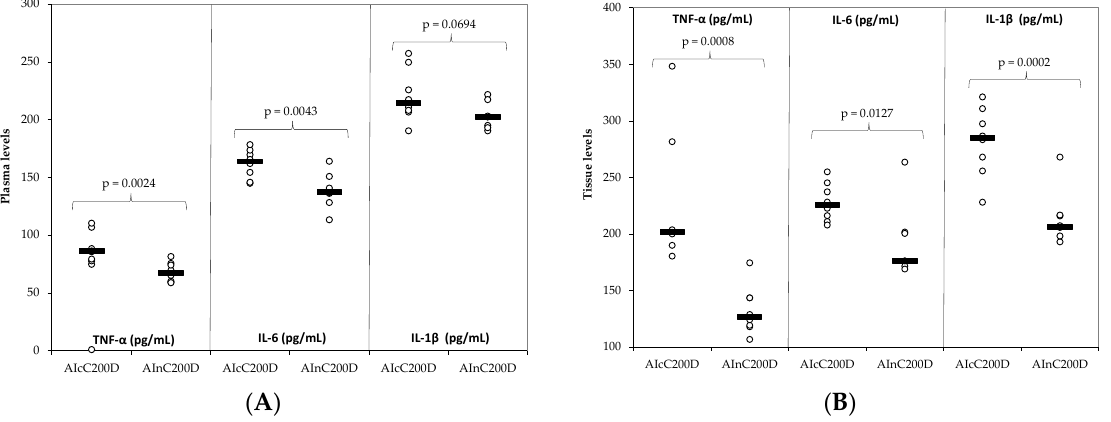
Figure 7. The increase in the therapeutic effect of diclofenac D when combined with conventional curcumin (cC) and curcumin nanoparticles (nC): ( A ) in the plasma ( B ) in the tissue. C—control; AI—Acute inflammation; D—Diclofenac; cC—conventional curcumin solution (200 mg/kg b.w.); nC—curcumin nanoparticles solution (200 mg/kg b.w.). The dots are the primary data and the line indicates the median value.